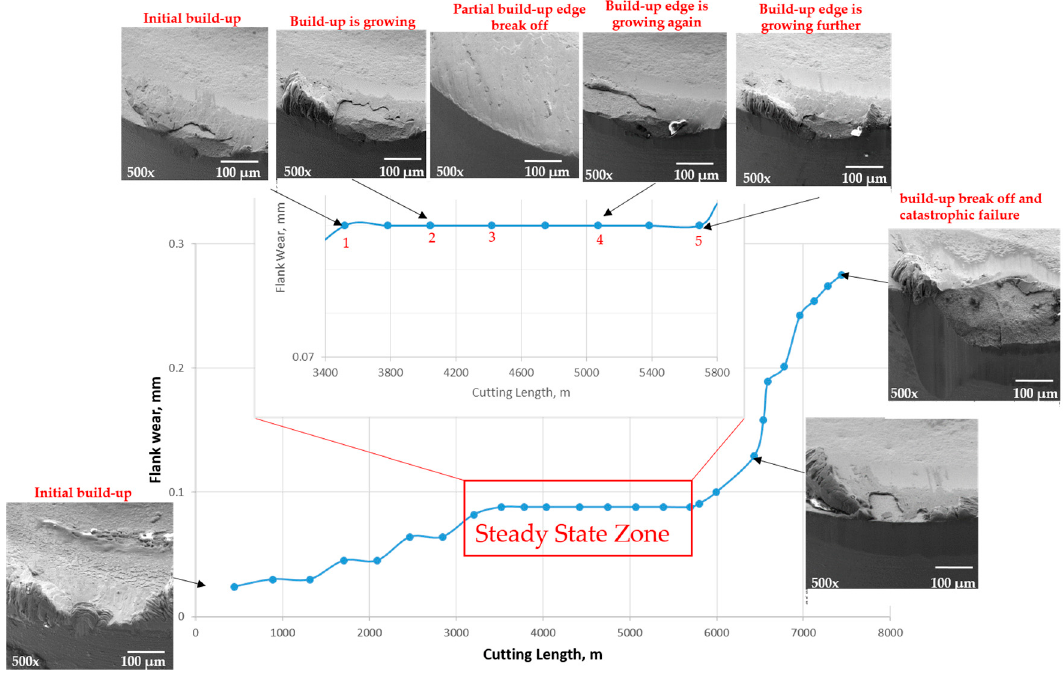
Figure 3. Relation between flank wear and cutting length for the uncoated carbide insert during machining AISI 304 stainless steel, combined with progressive Scanning Electron Microscopy (SEM) studies showing the Built-up edge (BUE) formation.